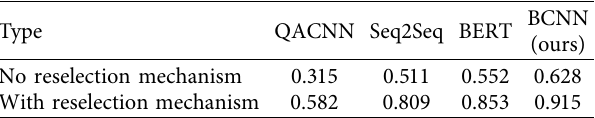
Table 2: Experimental results (accuracy) of effect comparison of whether there is a reselection mechanism.